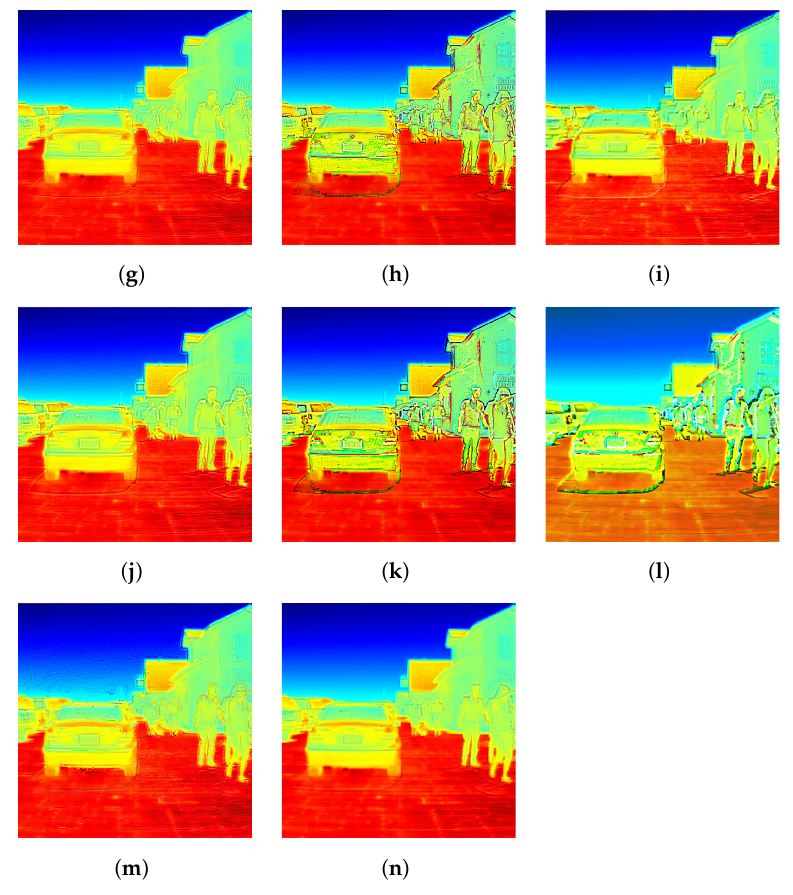
Figure A4. FLIR ADAS dataset [47] RGB: ( a ) Reference image; ( b ) PCA, ( c ) IHS; ( d ) BDSD; ( e )